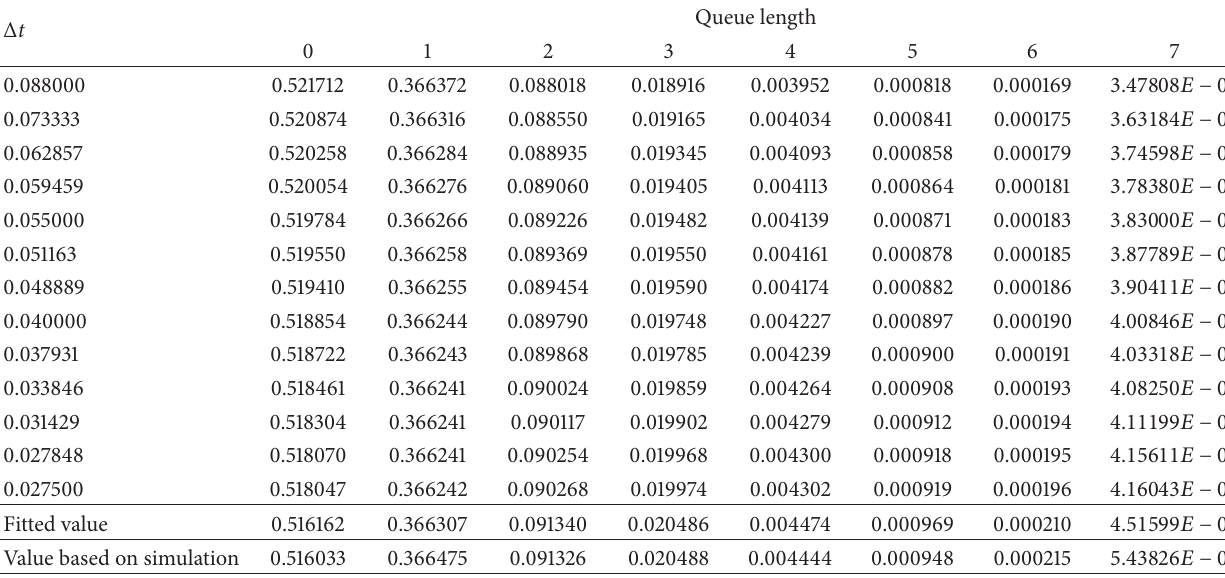
Table 2: Comparison of stationary queue length probabilities found by the numerical method using various other values of Δ𝑡 , the extrapolated values, and those obtained from the software “QtsPlus” ( 𝜅 1 , 𝜃 1 ) = (1.5, 2), ( 𝜅 2 , 𝜃 2 ) = (3.1, 2). Δ t